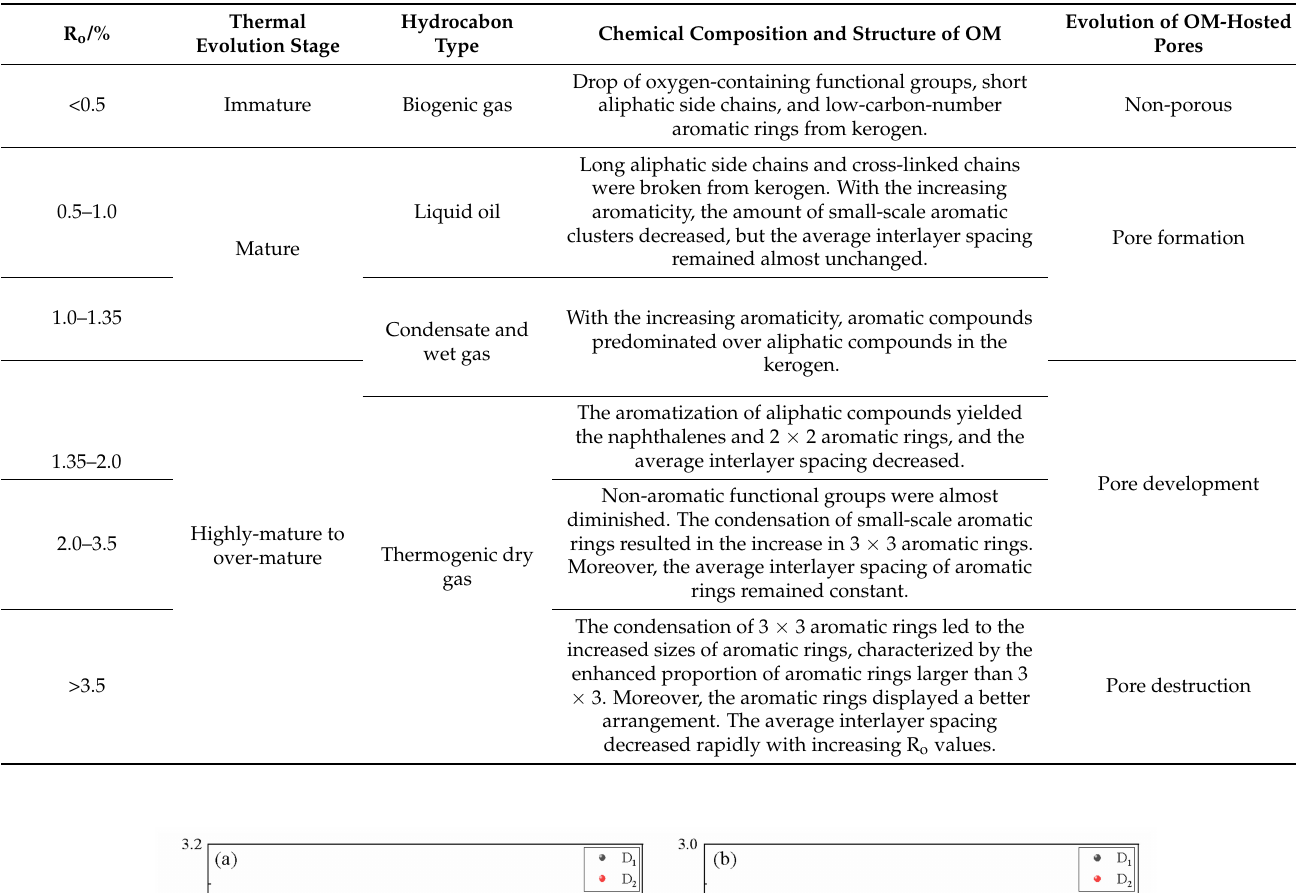
Table 1. Relationships between thermal evolution, chemical composition, chemical structure and pore evolution of OM in source rocks (modified from [112,118,122,127–129]).